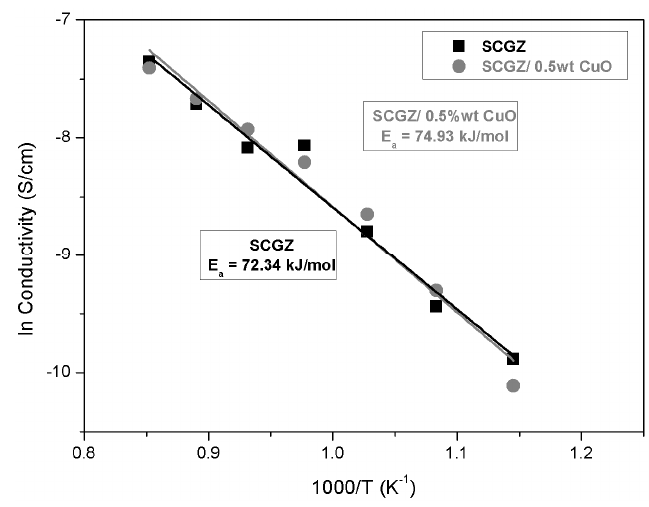
Figure 8. Activation energy of conduction ( E a ) for the SOEC having SCGZ electrolyte and 0.5 wt% CuO - added SCGZ electrolyte .